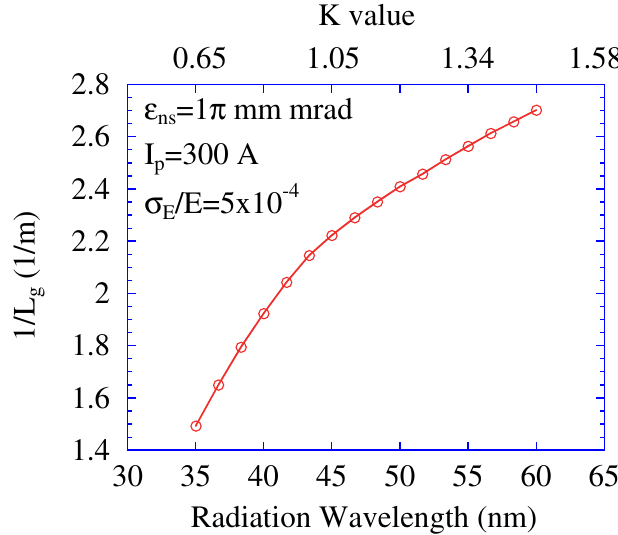
FIG. 9. (Color) Inverse of the 3D SASE gain length as a function of the wavelength. The undulator deflecting parameter, K , is indicated in the upper